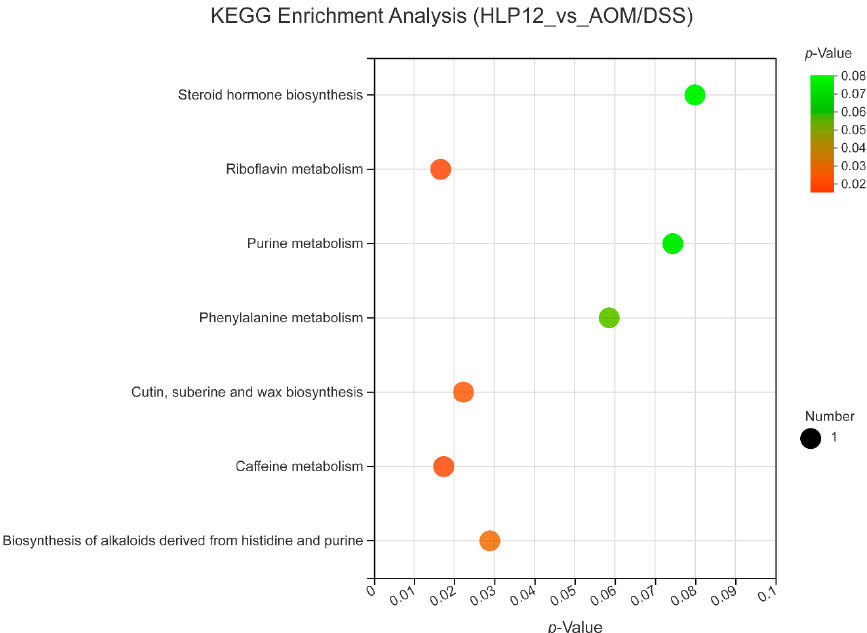
Figure 14. Metabolic pathway enrichment analysis of differentially presented metabolites of the mice in HLP12 and AOM/DSS groups ( n = 5). Generally, p < 0.05 indicates that this function is a significant enrichment item. The size of bubbles represents the amount of metabolites in the path- way.